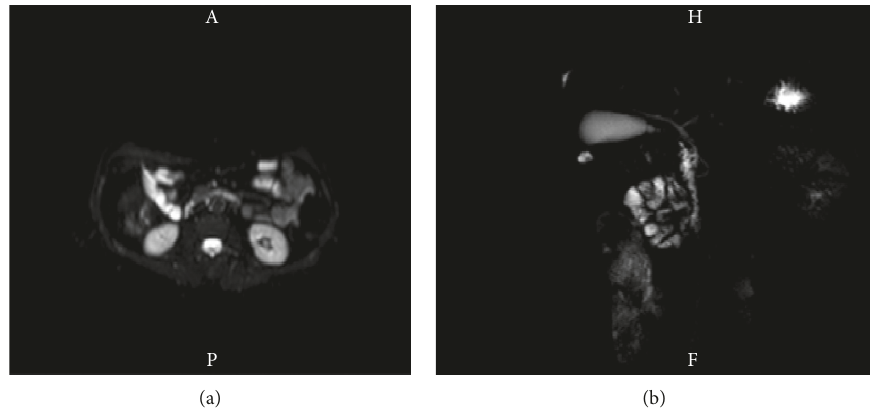
Figure 1: Normal representative magnetic resonance imaging of the (a) abdomen and (b) bladder and bile